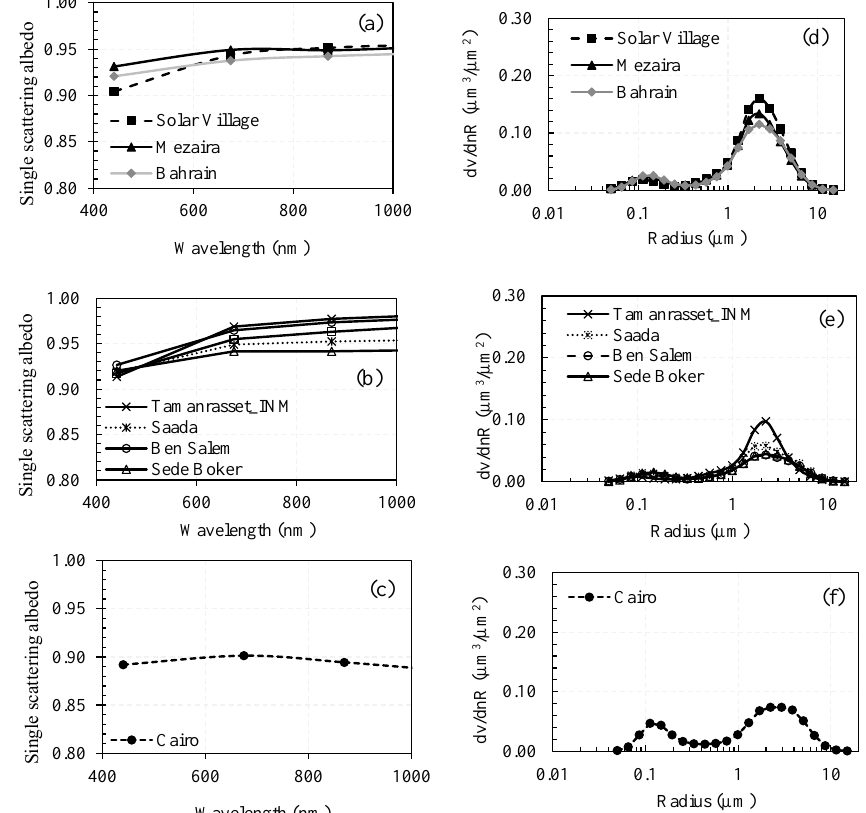
Figure 2. Characteristics of the single scattering albedo (SSA) at (a) Solar Village, Bahrain, and Mezaira; (b) Tamanrasset, Saada, Ben Salem, and Sedé Boqer; (c) Cairo. Volume size distribution at the eight sites: (d) Solar Village, Bahrain, and Mezaira; (e) Tamanrasset, Saada, Ben Salem, and Sedé Boqer; (f)